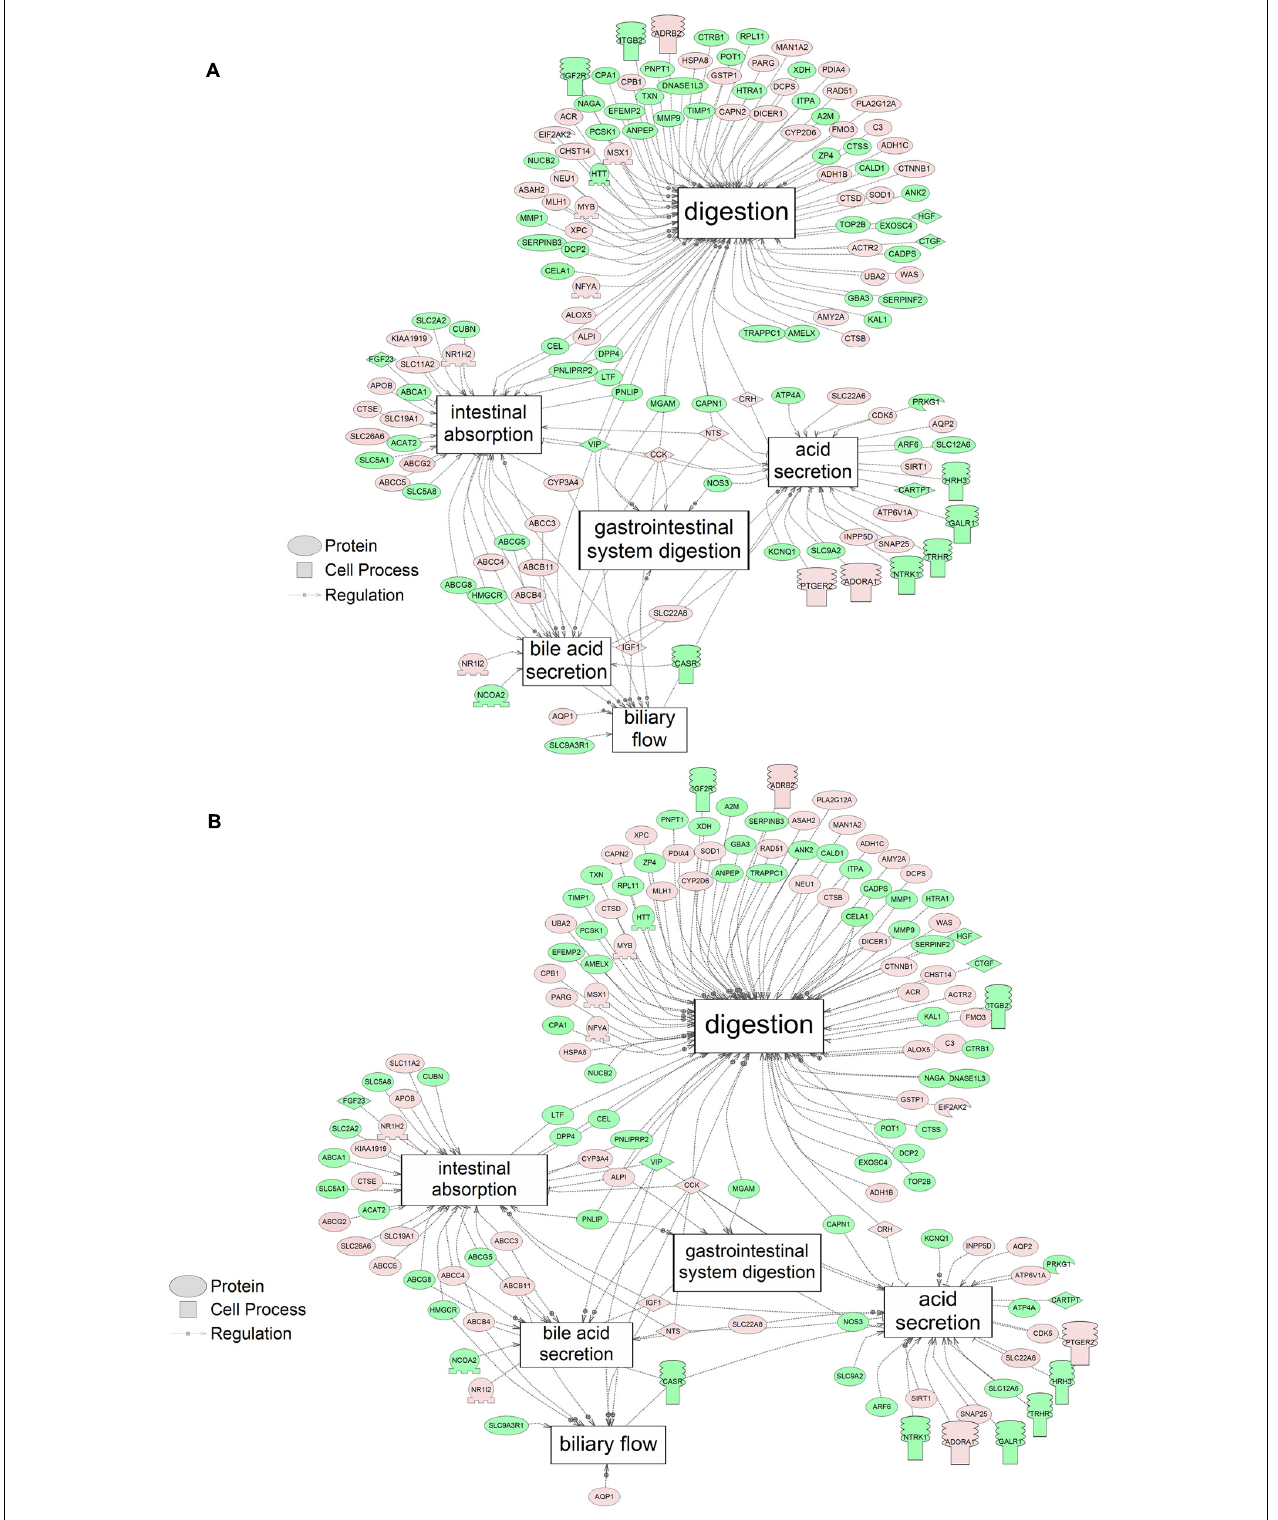
FIGURE 4 | Networks associated with gut function indicating altered gene regulation following exposure of S. tropicalis to 2 mg/L of S1 (A) and S2 (B) . Sub-network enrichment analysis (SNEA) was performed using Pathway Studio 9.0. Pink and red indicate that the transcript abundance was increased and green indicates that the transcript abundance was decreased ( p < 0.05). The abbreviations are the official gene symbol of the transcripts of the respective pathway ( Supplementary Tables S10, S11 ).